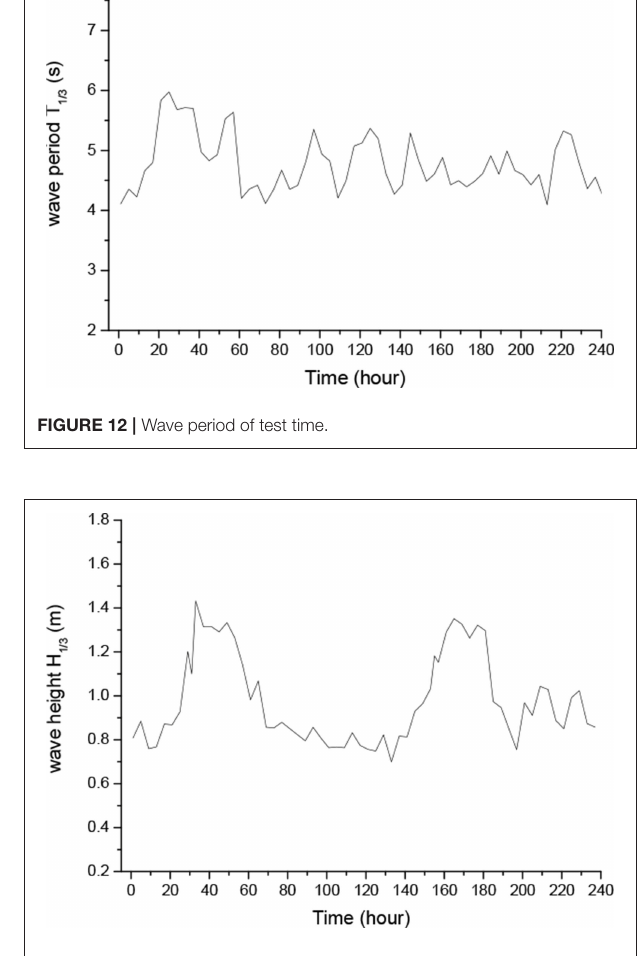
FIGURE 13 | Wave height of test